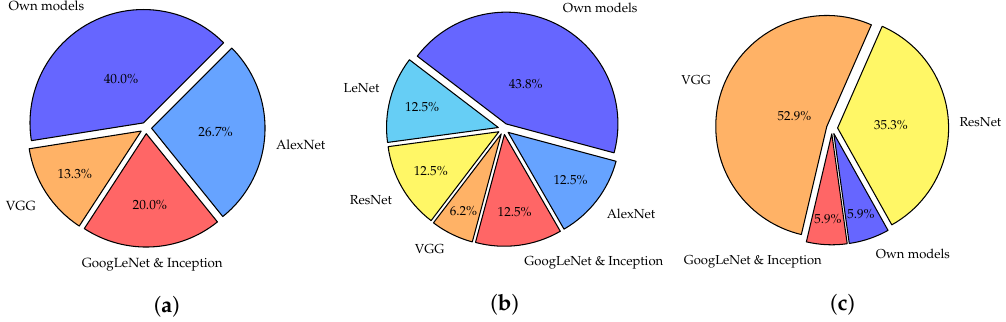
Figure 8. Distribution of CNN architectures used for: ( a ) fruit classification, ( b ) fruit quality control, and ( c ) fruit detection for automatic